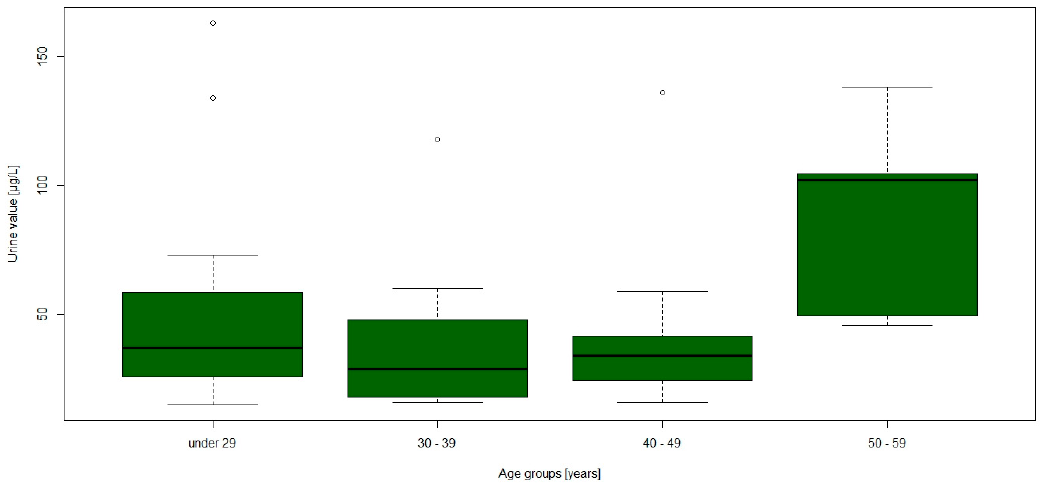
Figure 4. Boxplot of mercury in urine values stratified by age. Int. J. Environ. Res. Public Health 2017 , 14 , 0034